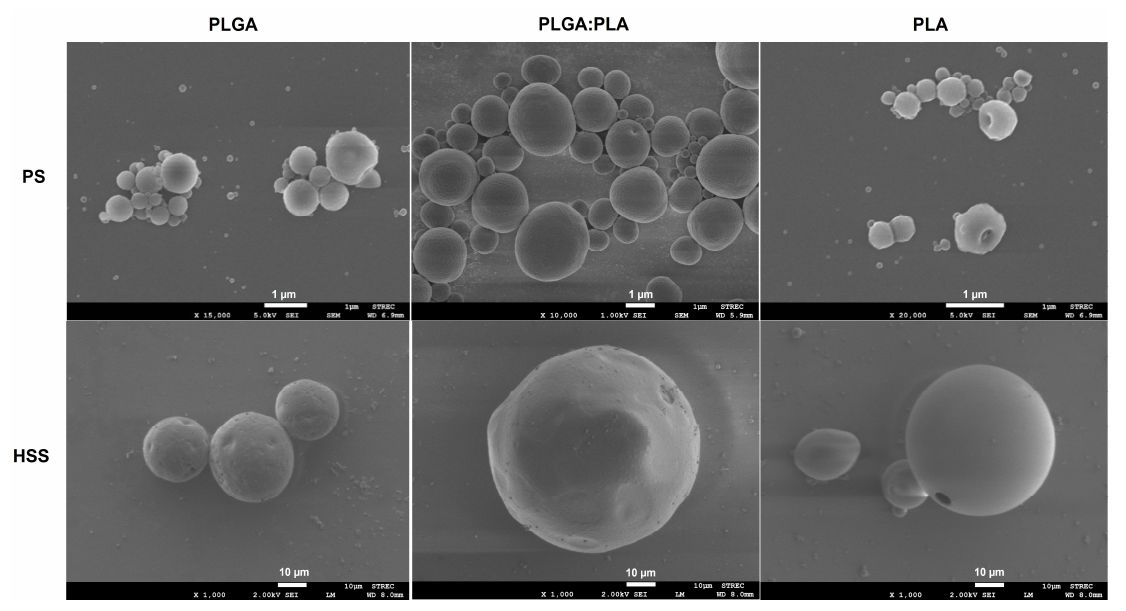
Figure 1. FE ‐ SEM images of ketorolac ‐ loaded microparticles. Scale bars in PS and HSS techniques Figure 1. FE-SEM images of ketorolac-loaded microparticles. Scale bars in PS and HSS techniques represent 1 μ m and 10 μ m, respectively. represent 1 µ m and 10 µ m, respectively.